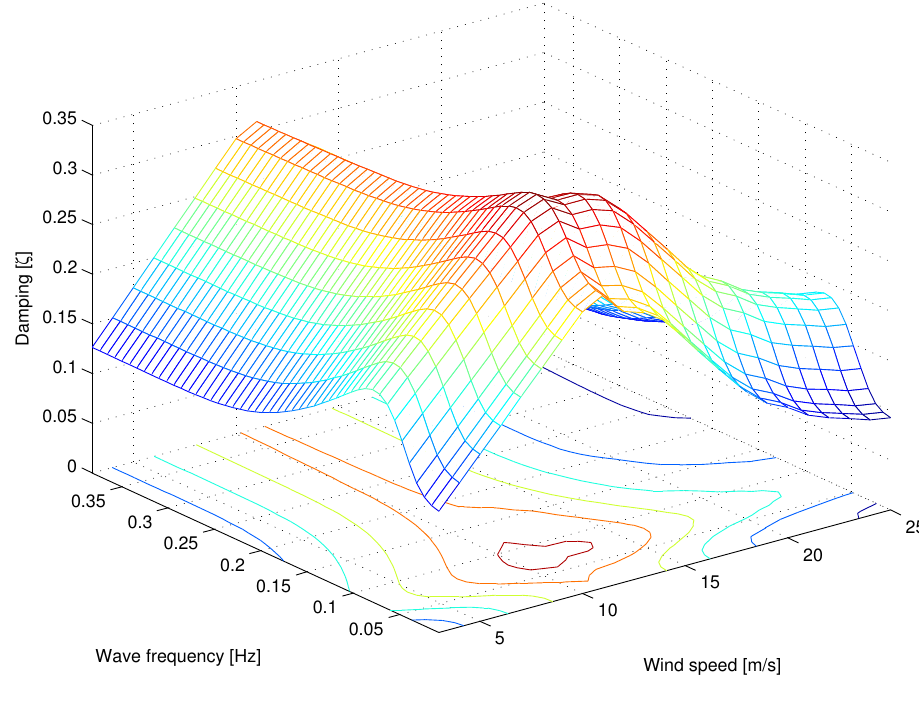
Figure 5. Open loop damping in platform pitch as a function of wave frequency and wind speed.